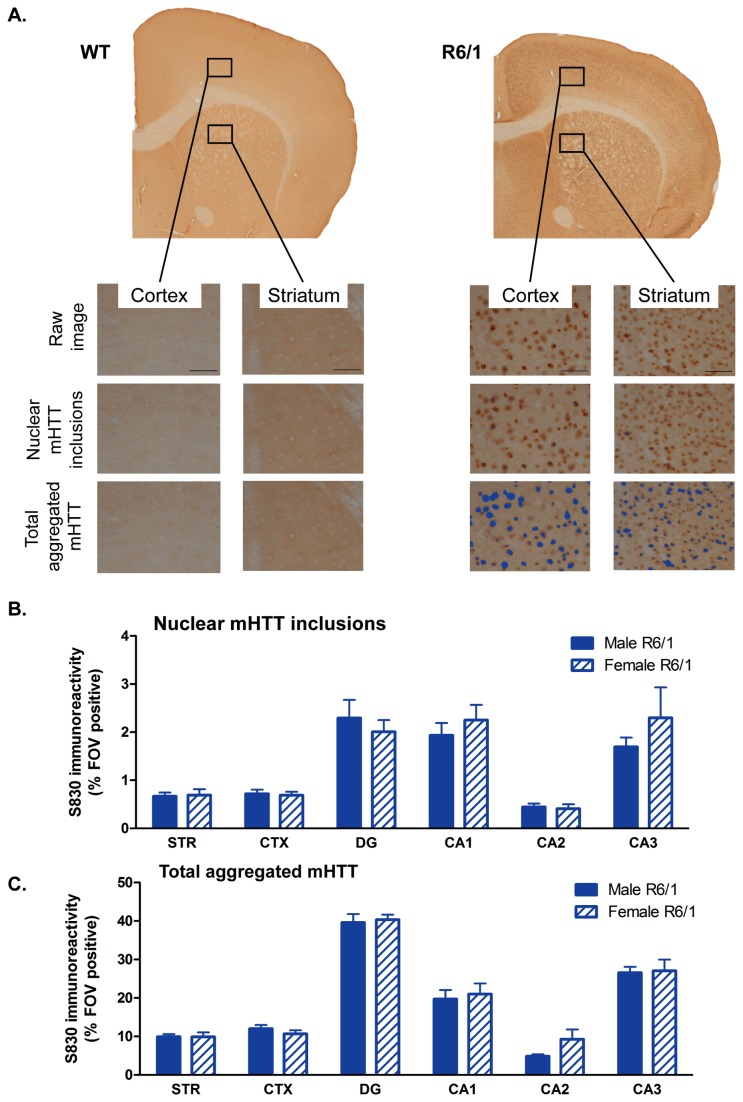
mHTT accumulation in R6/1 mice.(A) Representative coronal sections from 19 weeks’ old WT and R6/1 mouse brains stained with the S830 antibody for the detection of mHTT. Levels were quantified within seven brain regions using an intensity threshold-based image analysis tool optimized for the detection of nuclear inclusions, or total levels of aggregated mHTT (neuropil aggregates and diffuse nuclear accumulation, highlighted in blue); scale bar 50μm. Field of views (FOVs) were sampled in the cortex, striatum and hippocampal subfields. Percentage of FOVs positive for S830 stain of nuclear inclusions (B), and percentage of FOV positive for total aggregated mHTT (C), there were no significant differences between male and female R6/2 for either assessments. Regional differences in mHTT reflect cellular density. STR = striatum, CTX = cortex, DG = dentate gyrus, CA1 = hippocampal CA1 subfield, CA2 = hippocampal CA2 subfield, CA3 = hippocampal CA3 subfield. Analyzed using a two-way ANOVA (Gender X Region). All brain regions investigated: R6/1 male n=8-9, R6/1 female n=7-9. Data presented as means ± SEM.